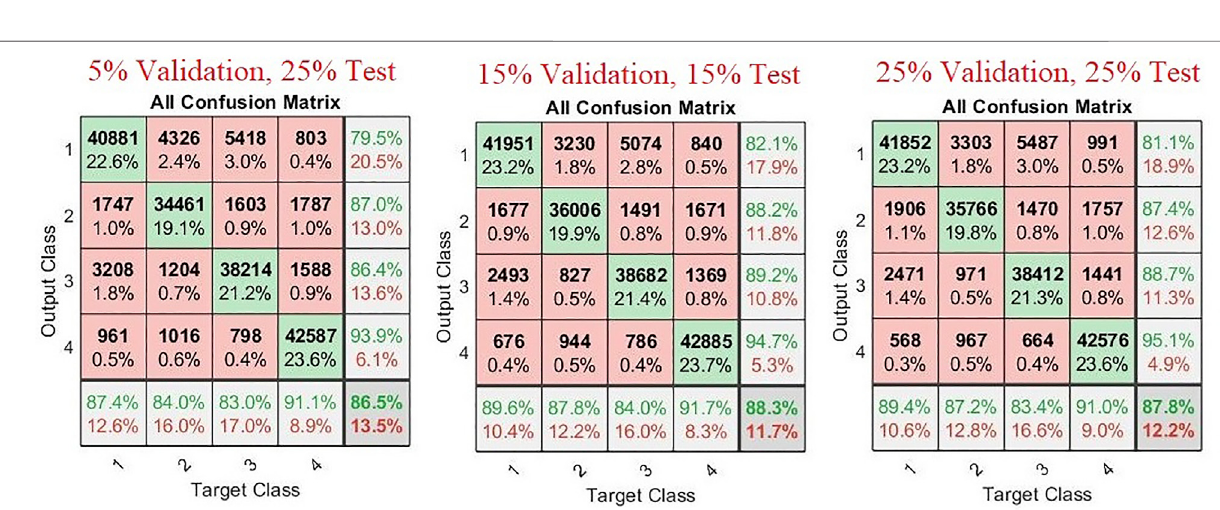
FIGURE 5 | Confusion matrices with different percentages of validation data and test